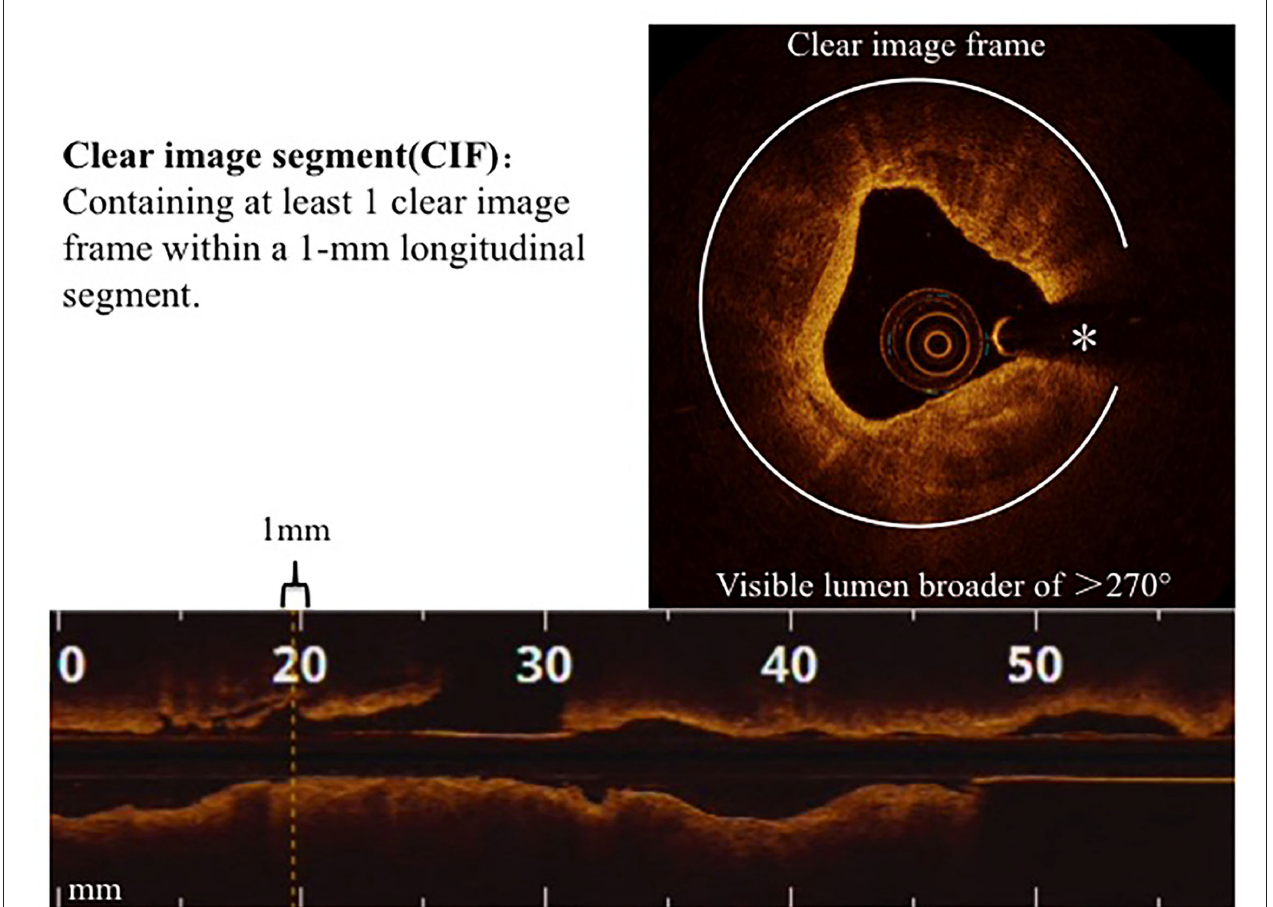
FIGURE 1 | Clear image segments (CIS). CIS and CIF are defined in the Methods section. *Guide-wire artifact.